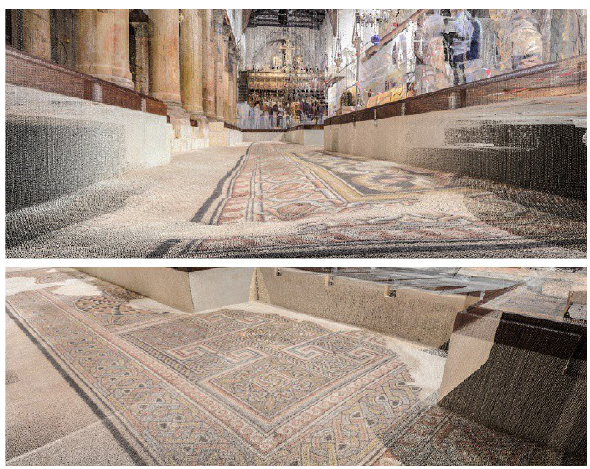
Figure 7. TLS data acquisition of Mosaic